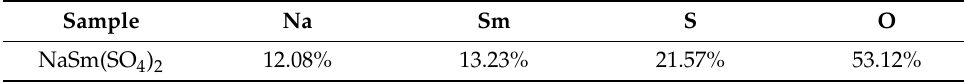
Figure 5. XRD analysis of NaSm(SO 4 ) 2. Table 3. EDS analysis of NaSm(SO 4 ) 2.